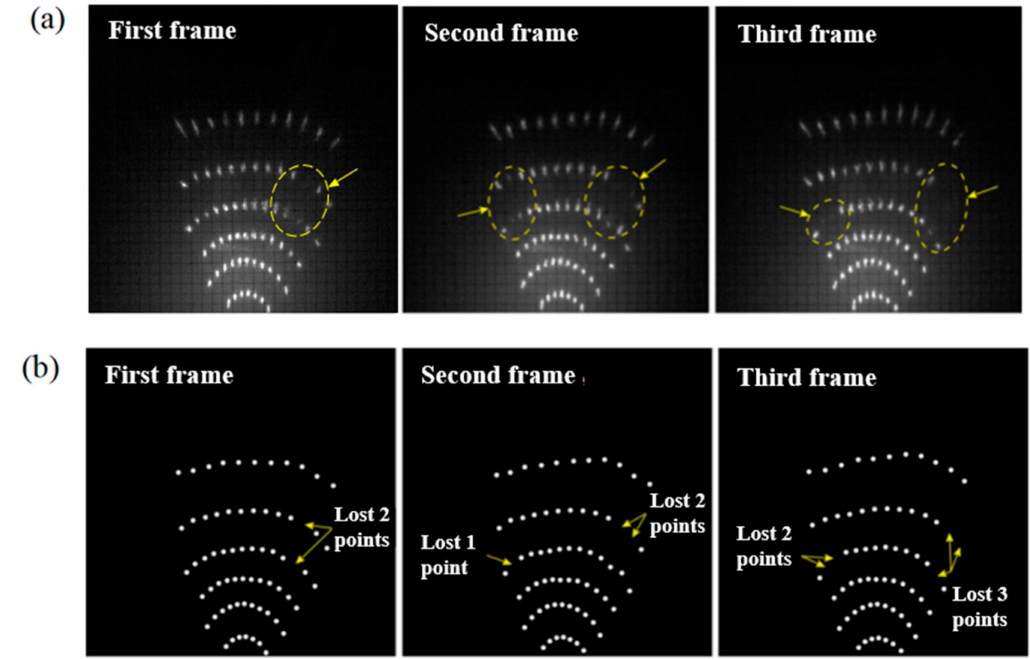
Figure 9. Missing points caused by the formation of floating oxides on the surface of the molten pool. ( a ) A set of reflection images taken in the 70 A current test (the camera frame rate is 26 Hz, the first frame corresponds to 15.46 s after arcing); ( b ) Corresponding image processing results of the three reflection images in ( a ).